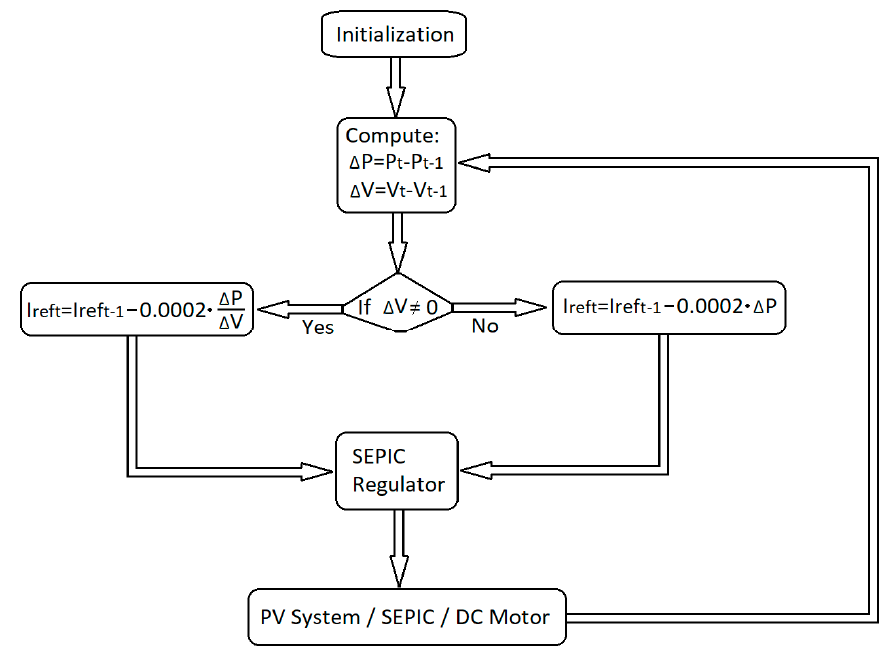
Figure 16. P&O algorithm adapted to the current system.